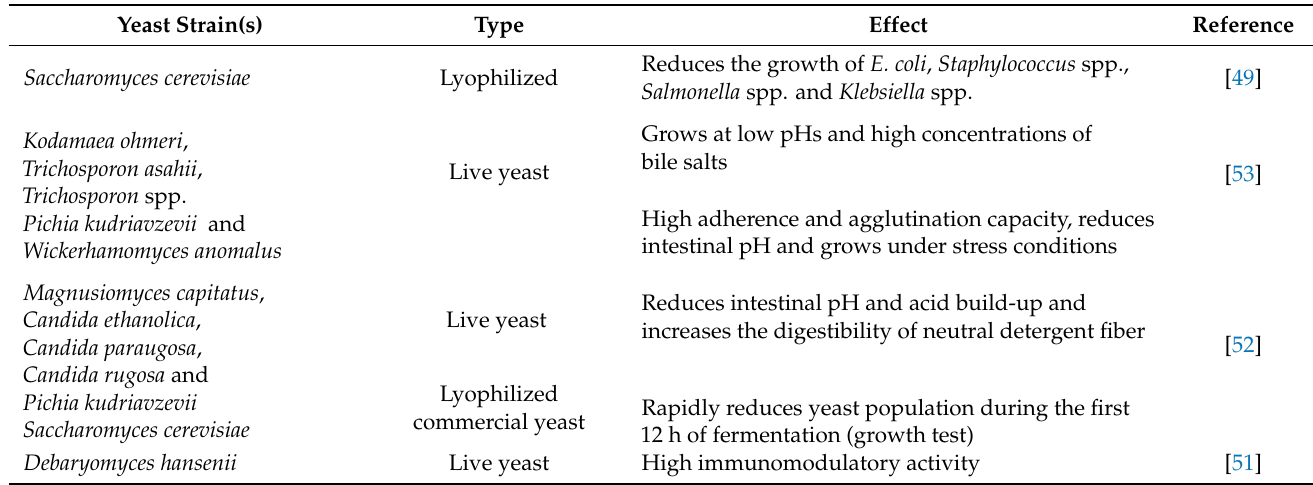
Table 1. Effects of probiotic yeasts in in vitro